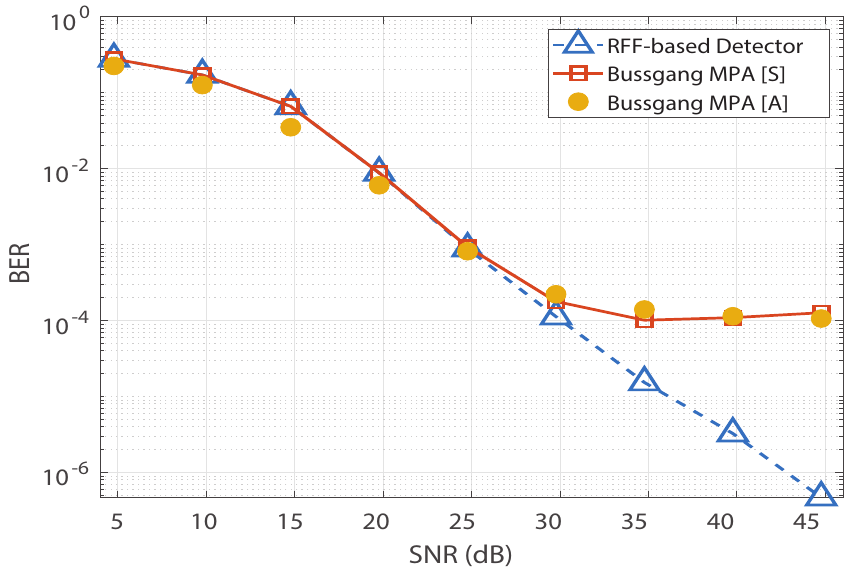
Figure 5. BER vs. SNR validation for the Bussgang-based detector for a Rayleigh channel.